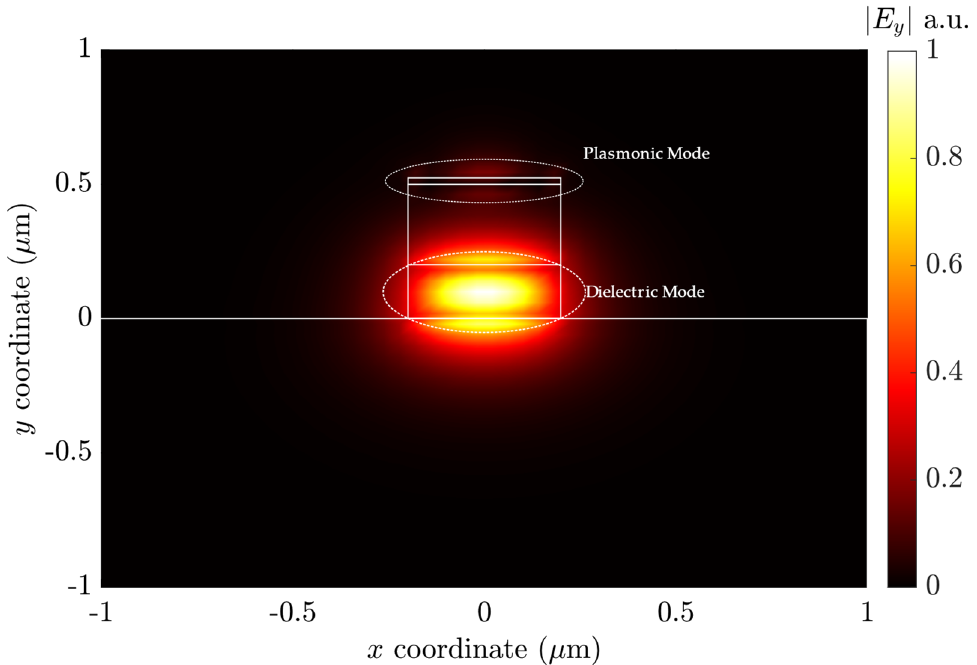
Figure 9. The Y-component of the electric field magnitude for the hybrid LRSPP mode.